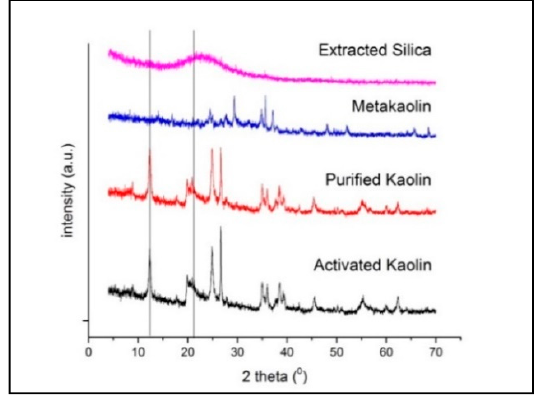
Figure 1. X-Ray Diffraction data for the raw precursor materials. Figure 1. X-Ray Di ff raction data for the raw precursor